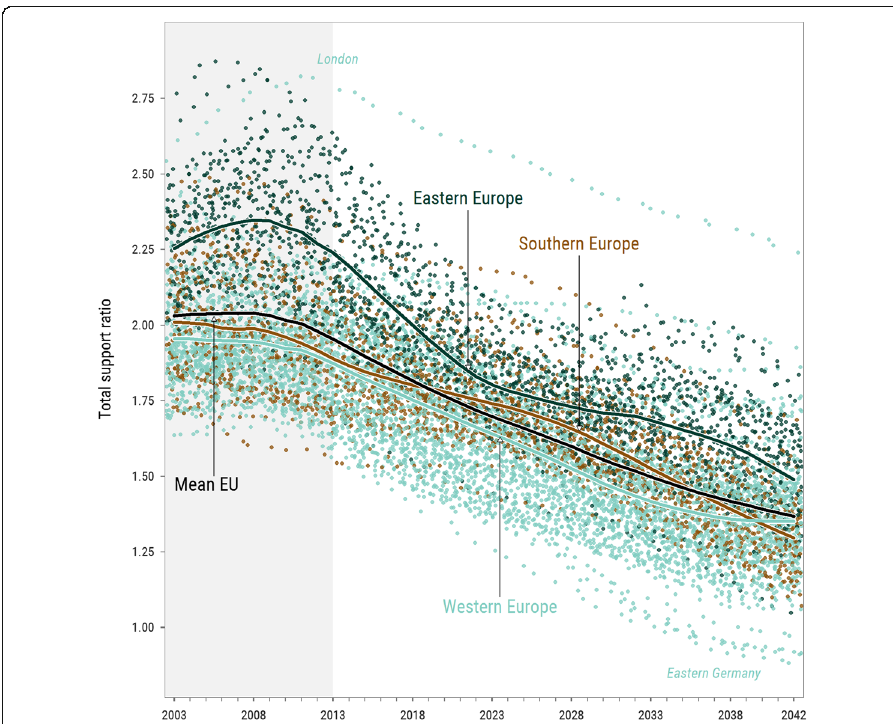
Fig. 2 Total support ratio dynamics in Europe during the period 2003 – 2042, NUTS-2 regions, four subregions ’ averages, and the European average. Notes : Each NUTS-2 region ’ s TSR value in each year of the study period is represented with a point colored according to EuroVoc definition of European subregions. Lines represent group averages. The most prominent outliers (London — top ; and five regions of Easrtern Germany, excl. Berlin — bottom ) are also labeled. Observed period marked with a light-gray